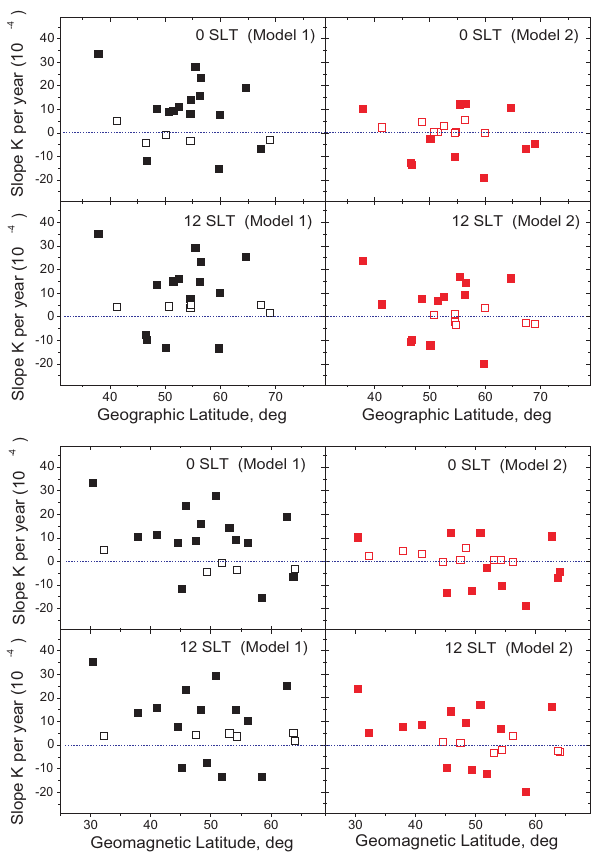
Fig. 3. A dependence of the hm F2 trend magnitude on geographic (top panel) and geomagnetic (bottom panel) latitude for two models, 00 and 12 SLT. Filled in symbols correspond to significant trends at a 95% confidence level. Note the absence of any pronounced dependence.